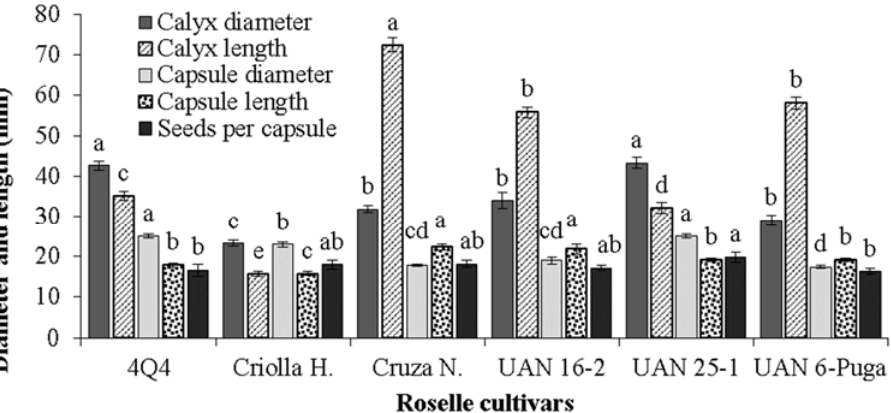
Figure 4. Diameter and length of calyx and capsule and number of seeds per capsule of different roselle cultivars. Different letters on bars corresponding to the same response variable indicate significant differences between cultivars according to the Tukey test ( p ≤ 0.05). Vertical bars correspond to the standard deviation.